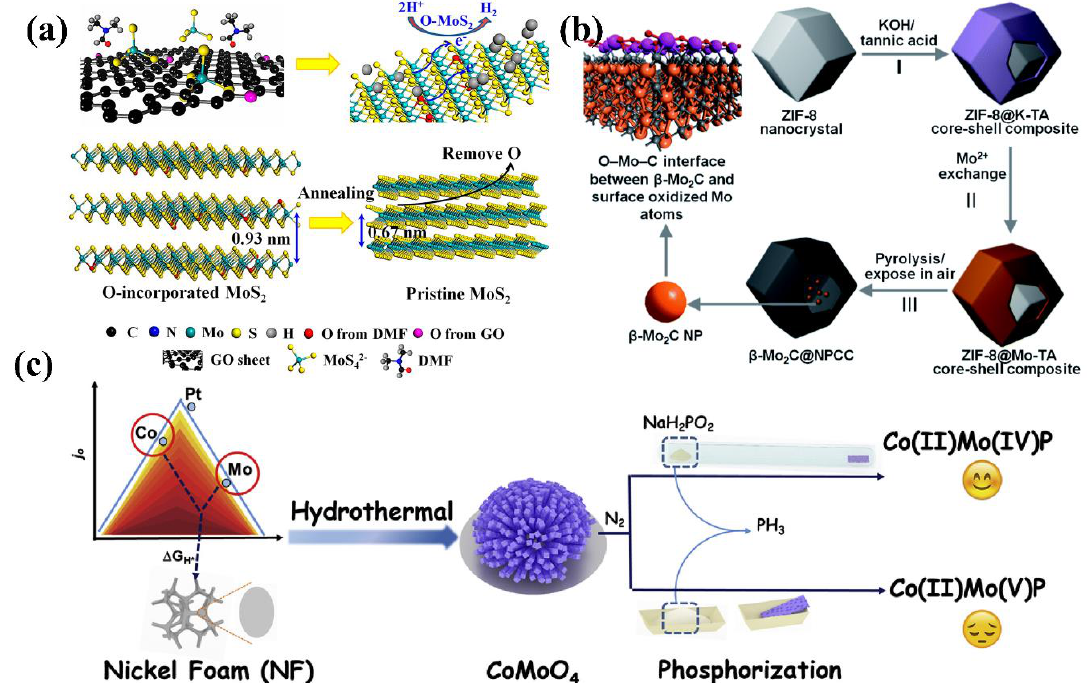
Figure 3. ( a ) growth scheme of vertically aligned oxygen-incorporated MoS 2 nanosheets decorated on reduced graphene oxide (O-MoS 2 / rGO) catalysts. Copyright 2016 American Chemical Society. ( b ) synthetic scheme for the preparation of β -Mo 2 C nanoparticles confined within hollow capsules of N-doped porous carbon ( β -Mo 2 C@NPCC). Copyright 2020 Royal Society of Chemistry. ( c ) schematic illustration of the synthesis of CoMoP catalysts. Copyright 2019